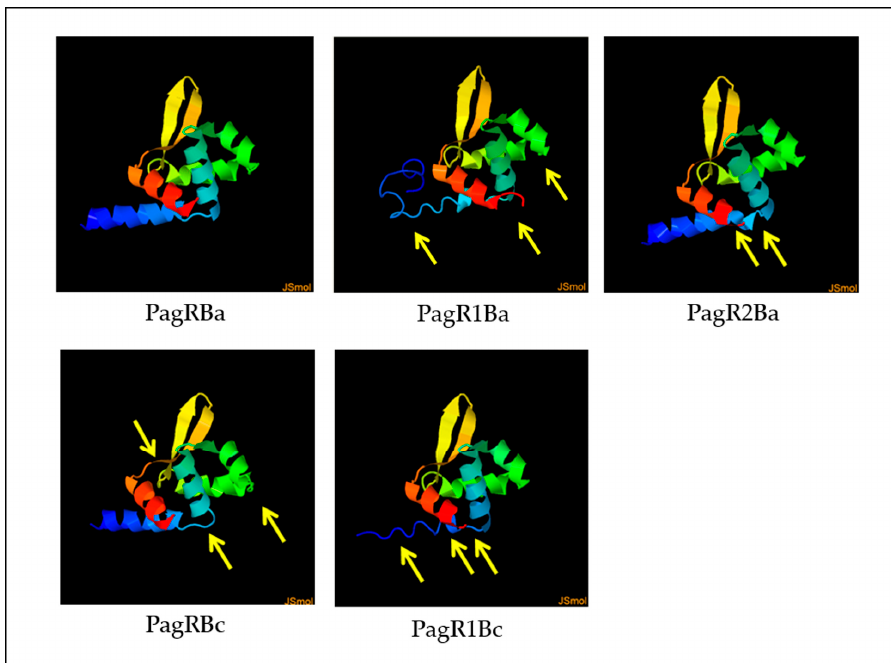
Figure 2. Predictive 3D protein models of PagR homologues. Structure models were constructed by the Phyre2 online tool, based on the crystal structure of PagR from B. anthracis [33]. Differences in protein folding are marked with yellow arrows of PagR homologues of emetic reference strain B. cereus F4810/72 and B. anthracis Sterne. Designations of PagR homologues as shown in Figure 1.